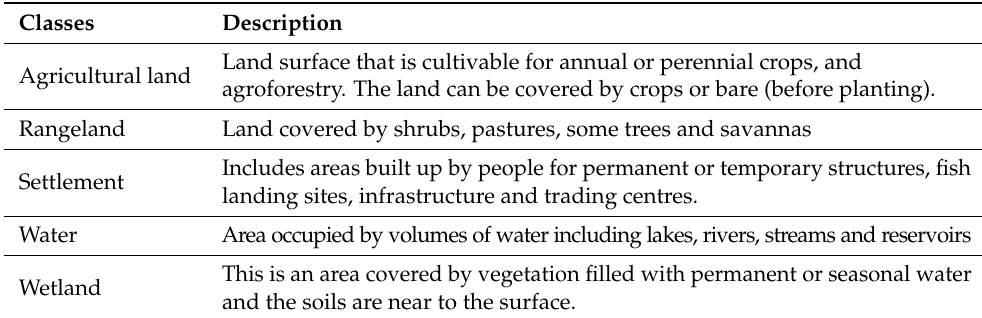
Table 2. Description of the land use land cover classes within the immediate catchment of Lake